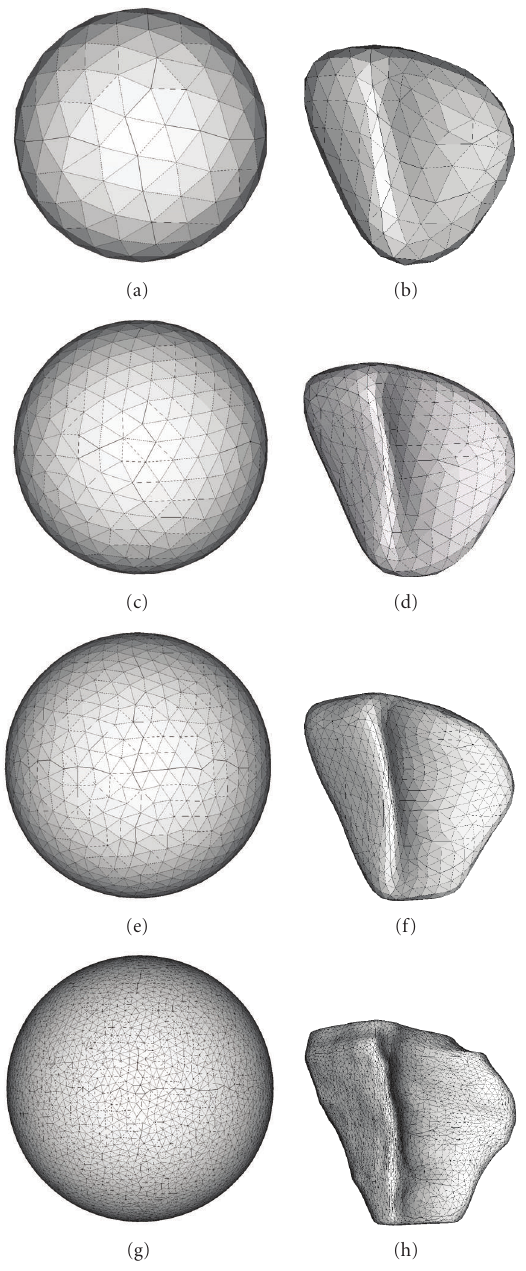
Figure 7: Each row shows a mesh on the sphere and the corresponding right ventricular mesh obtained by propagating the mesh from the sphere to the right ventricular surface. The numbers of mesh vertices for the four rows are 200, 500, 1000, and 5000. The corresponding mean ± std (min, max) Q values for the mesh on the sphere are 0 . 93 ± 0 . 07(0 . 75,1), 0 . 94 ± 0 . 06(0 . 78,1), 0 . 93 ± 0 . 07(0 . 77,1), and 0 . 95 ± 0 . 05(0 . 76,1), and for the right ventricular mesh are 0 . 85 ± 0 . 07(0 . 68,0 . 99), 0 . 84 ± 0 . 06(0 . 62,0 . 99), 0 . 86 ± 0 . 06(0 . 65,0 . 99), and 0 . 85 ± 0 . 07(0 . 63,0 . 99).